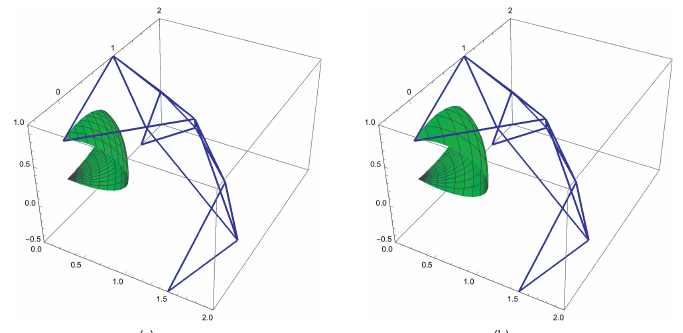
Figure 6: The truncated triangular Meyer-König-Zeller surfaces with ( m = 3, n = 1) (a) and ( m = 3, n = 3) (b).